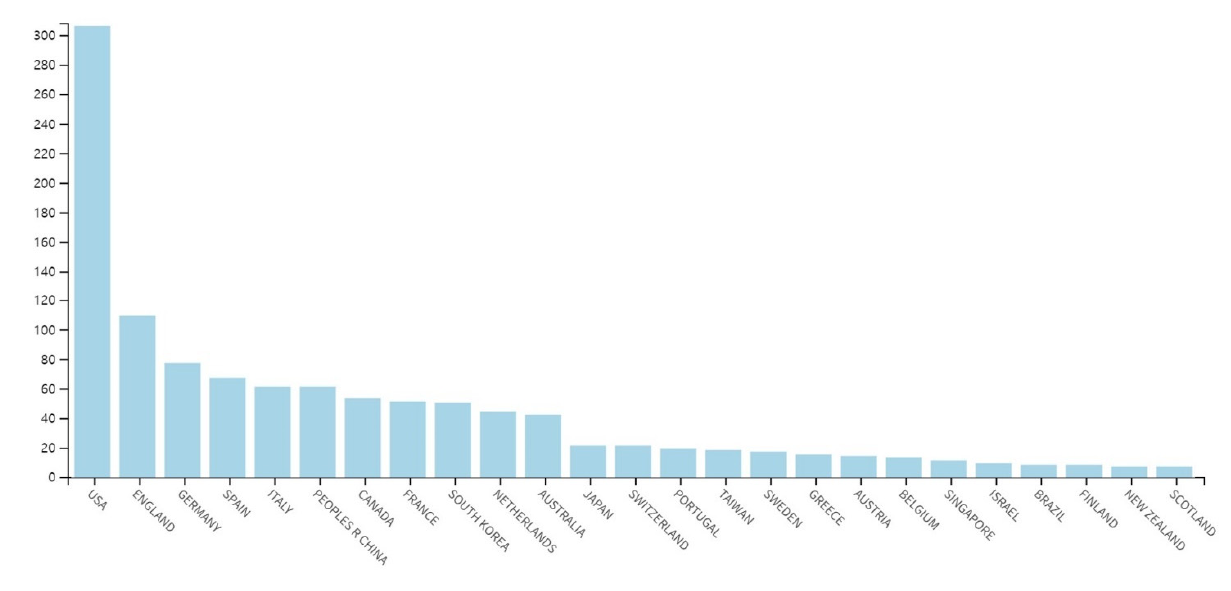
Figure 6. Most prolific countries. Table 7. The top 10 most prolific countries. Table 7. The top 10 most prolific